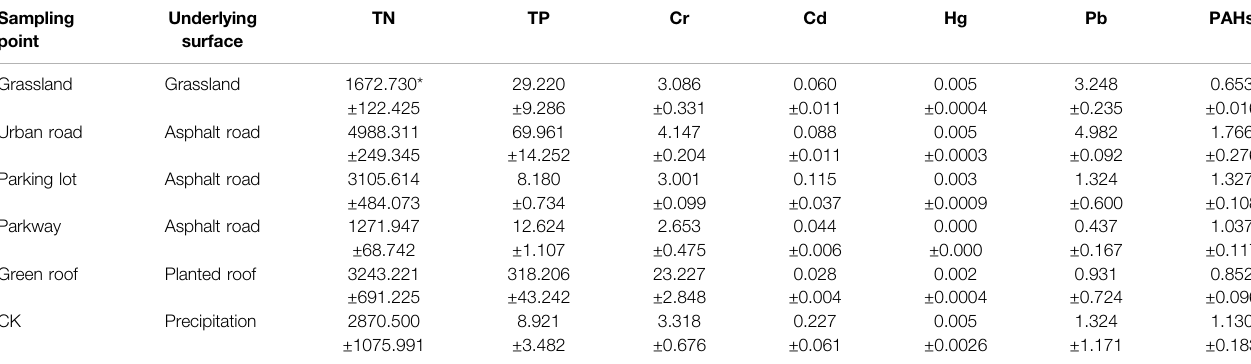
TABLE 2 | EMC values of storm runoff on different underlying surfaces (units: μ g/L). Sampling point